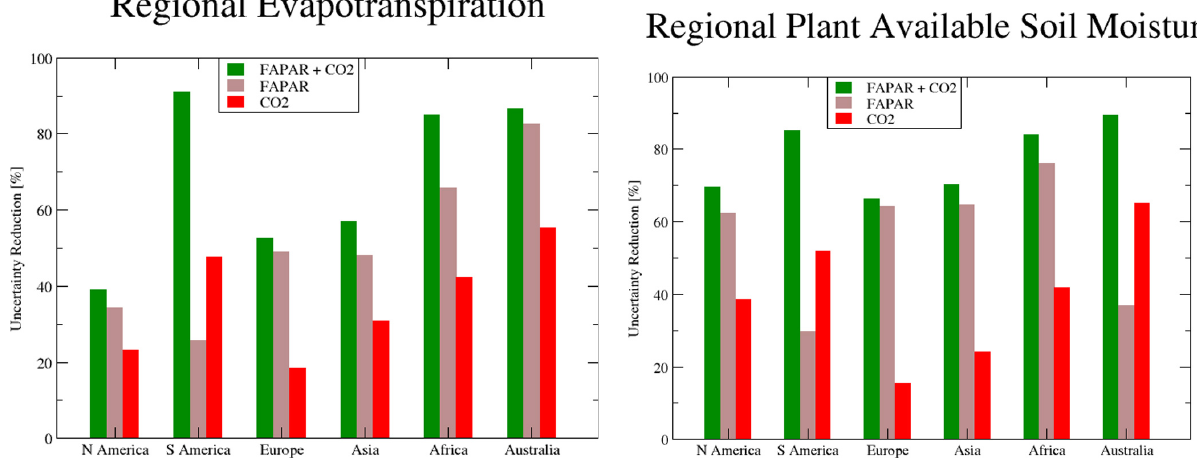
Fig. 8. Reduction in uncertainty in evapotranspiration (left hand panel) and plant available soil moisture (right hand panel) over six regions from MERIS sensor for a 14-yr mission. For assimilation of CO 2 (red) and FAPAR (brown) separately and jointly (green).